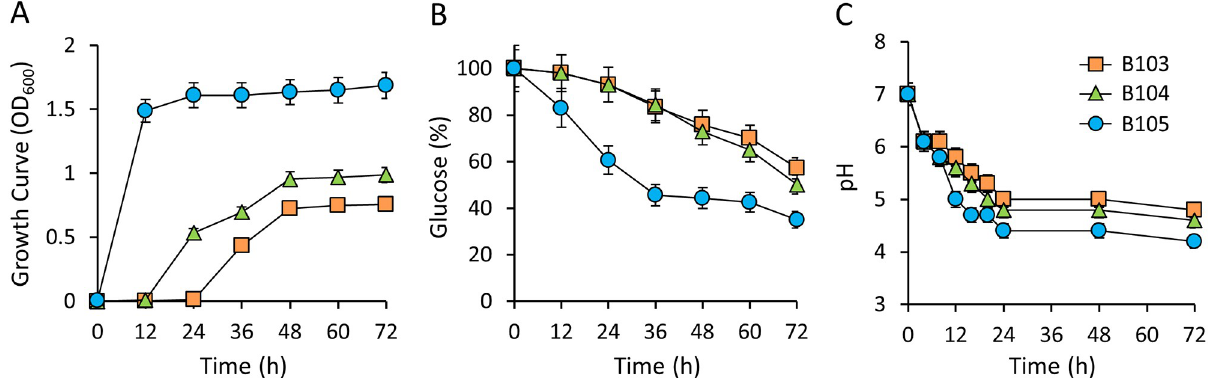
Fig 5. Effects of glucose utilization by LAB. Growth curve (A), glucose utilization (B), and pH-change (C) in MRS medium. Values are means of data from triplicate experiments each of which contained three technical replicates, with the SD indicated by vertical bars.